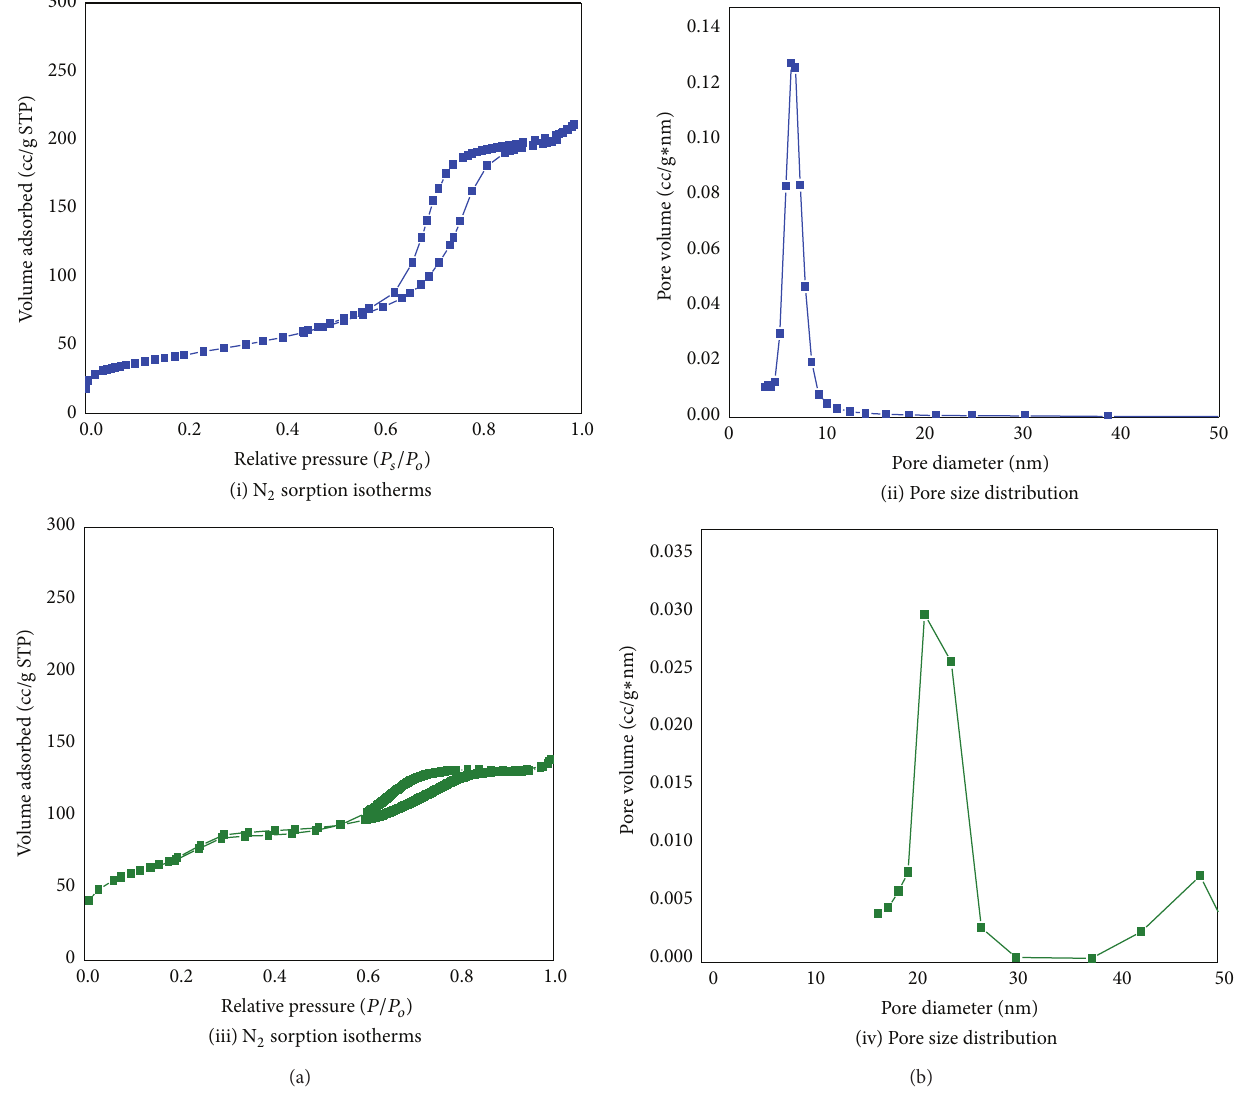
Figure 4: (a) N 2 sorption isotherms: (i) SOD-OS and (iii) SOD-TC. (b) Pore size distribution: (ii) SOD-OS and (iv)